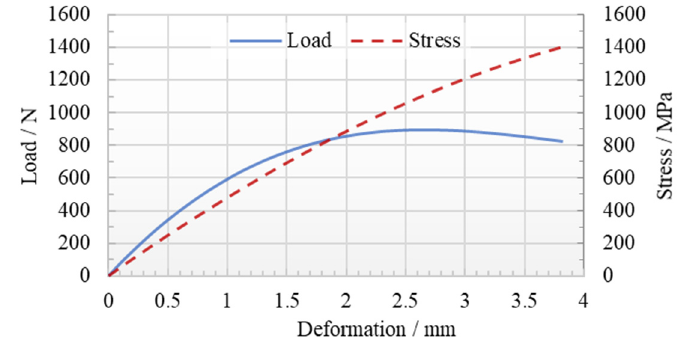
Figure 4. The characteristic curve of the designed slotted disc spring.